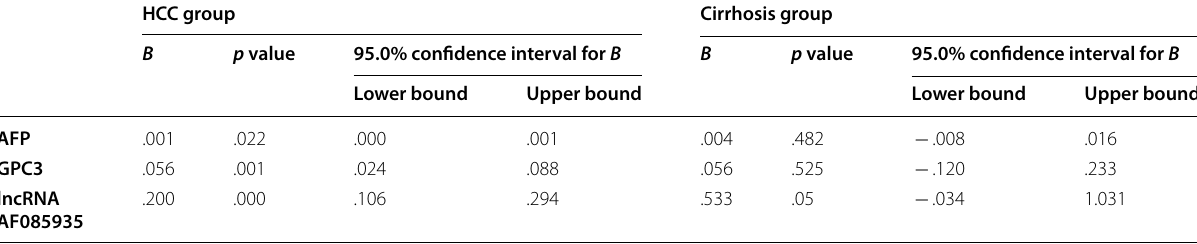
.008 .016 − .120 .233 − .034 −